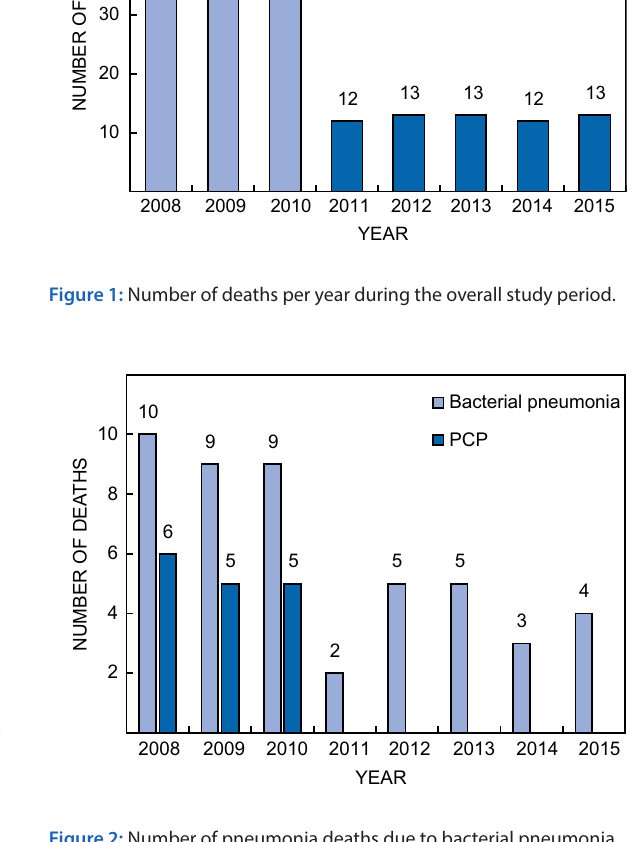
Figure 2: Number of pneumonia deaths due to bacterial pneumonia and pneumocystis pneumonia (PCP) during the overall study period.